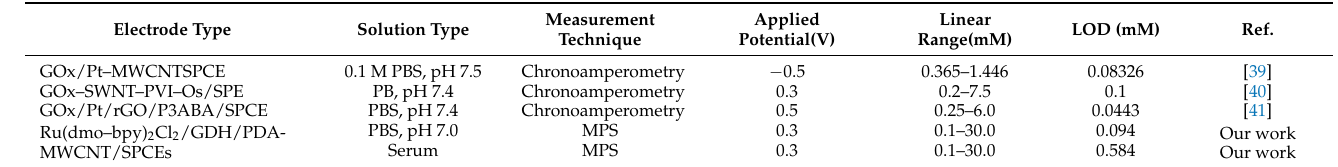
Figure 7. ( a ) Cyclic voltammograms and ( b ) multi-potential step (MPS) results of measuring glucose at concentrations of 0.0, 0.1, 0.5, 1.0, 5.0, 10.0, 15.0, 20.0, and 30.0 mM in serum. ( c ) Calibration curve of glucose concentration from 0.0 to 30.0 mM in serum at 0.3 V of MPS in ( b ). Table 3. Comparison with other glucose sensors reports based on